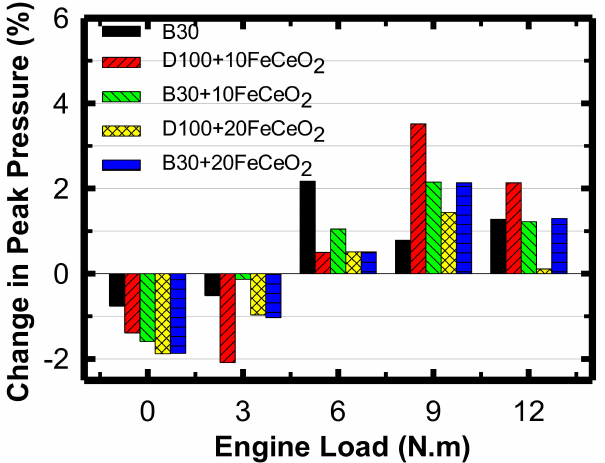
Figure 7. The change in cylinder peak pressure for different fuel conditions relative to mineral diesel base fuel